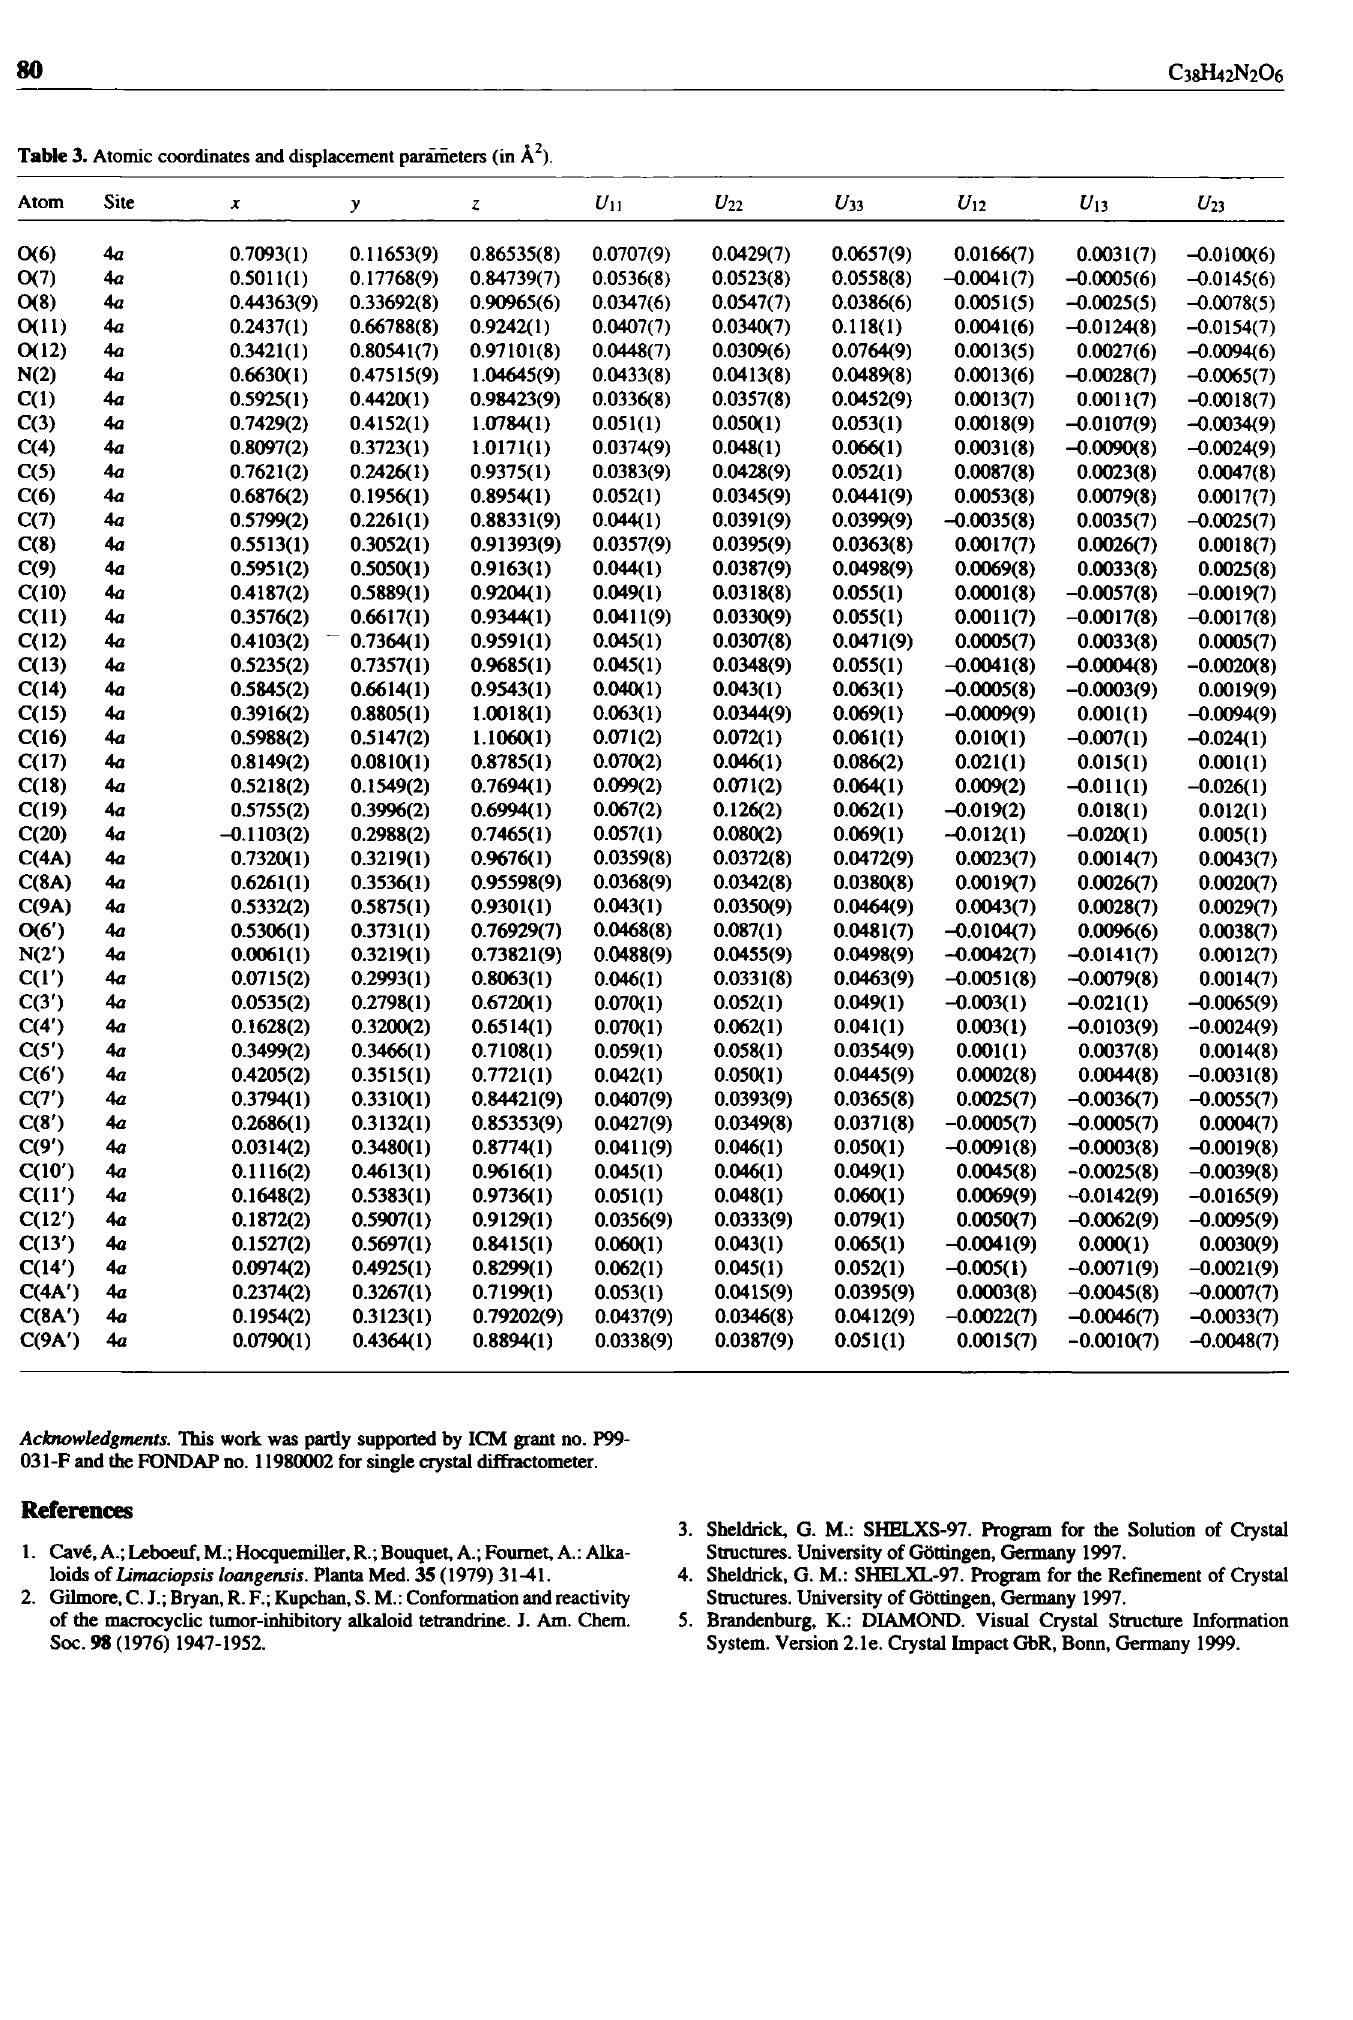
Table 3. Atomic coordinates and displacement parameters (in Ä 2